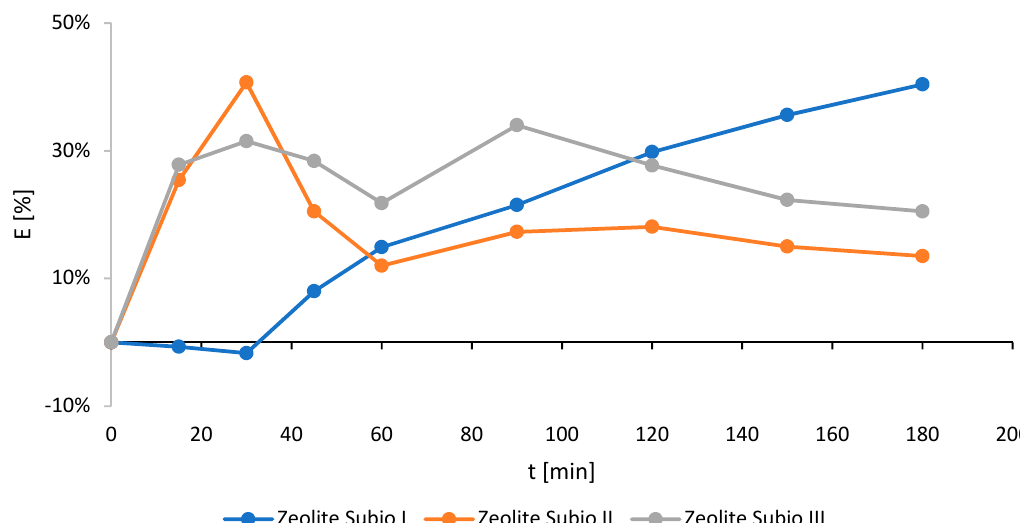
Figure 2. E ff ect of Zeolite Subio’s particle size on the ammonium ions removal e ffi ciency (E) (particle Figure 2. Effect of Zeolite Subio’s particle size on the ammonium ions removal efficiency (E) (particle size I: 0.5–1.0 mm; II: 0.2–0.5 mm; and III: 0.0–0.2 mm). size I: 0.5–1.0 mm; II: 0.2–0.5 mm; and III: 0.0–0.2 mm).